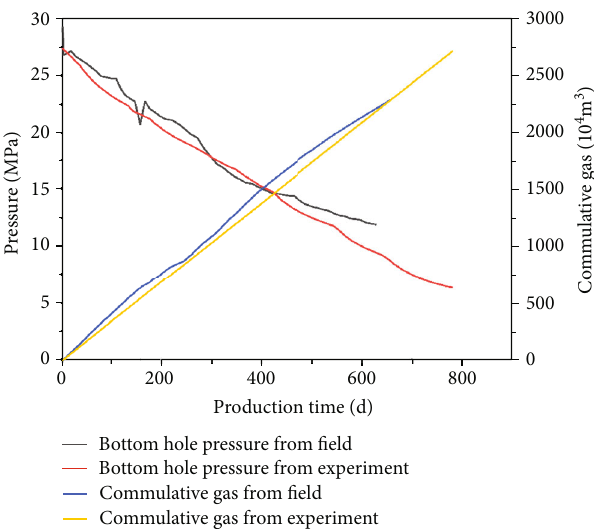
Figure 12: Model experiment and similarity transformation results of Su-1 well.